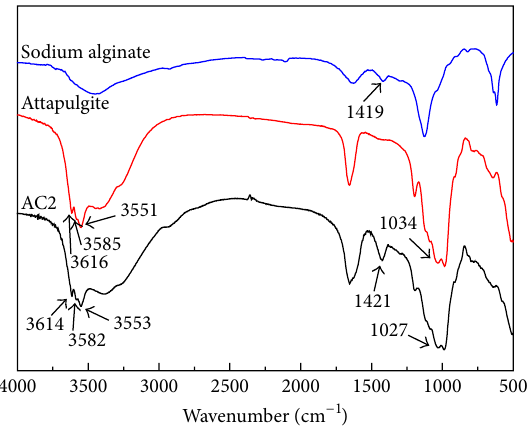
Figure 4: The powder X-ray diffraction pattern of the attapulgite and attapulgite